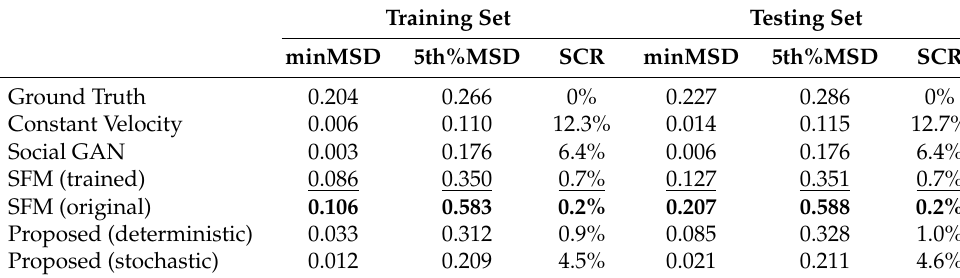
Table 6. Evaluation of MSD Metrics.